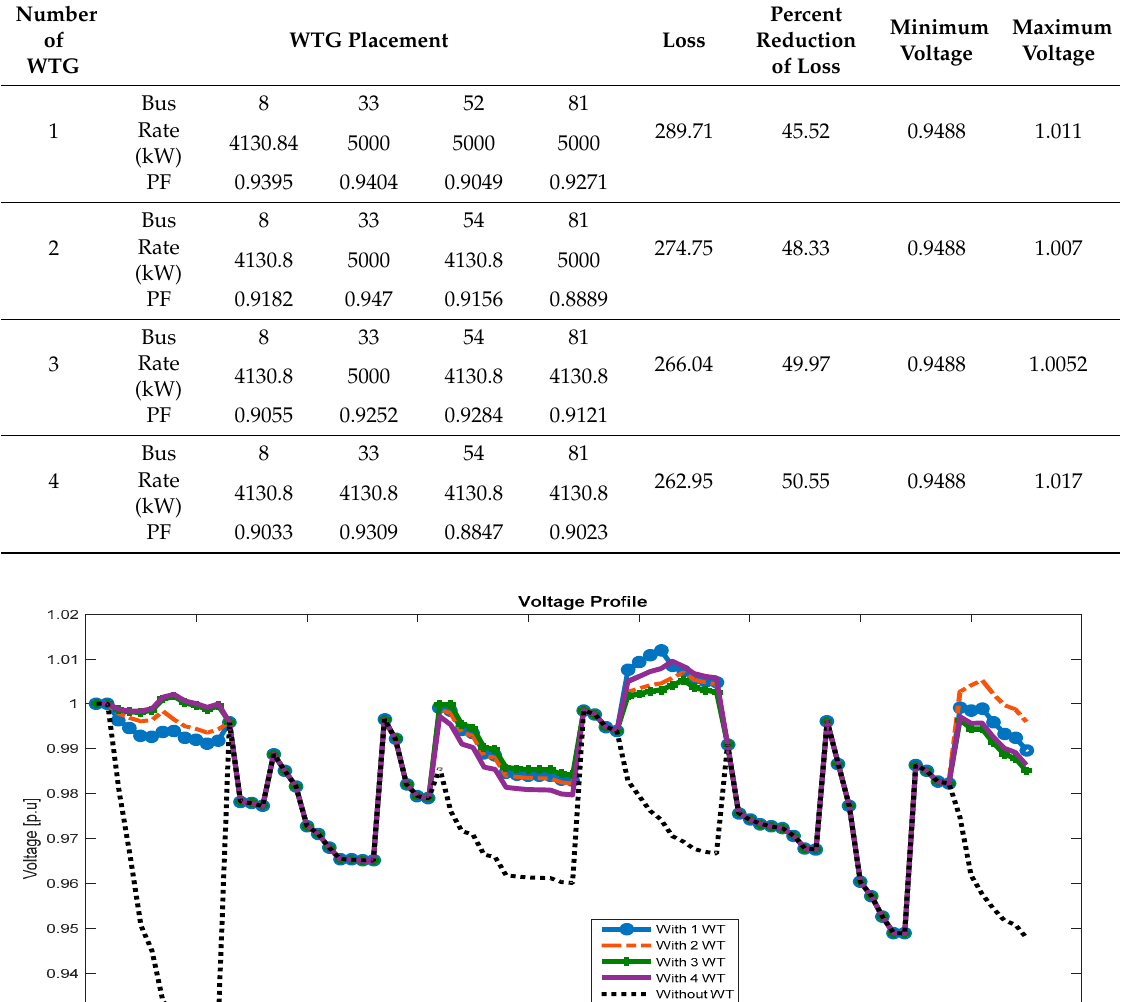
Table 4. Results of WT site selection for84-bus grid with respect to constraints.